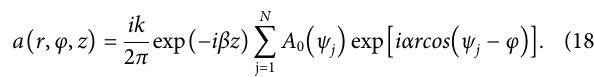
Frontiers in Physics |